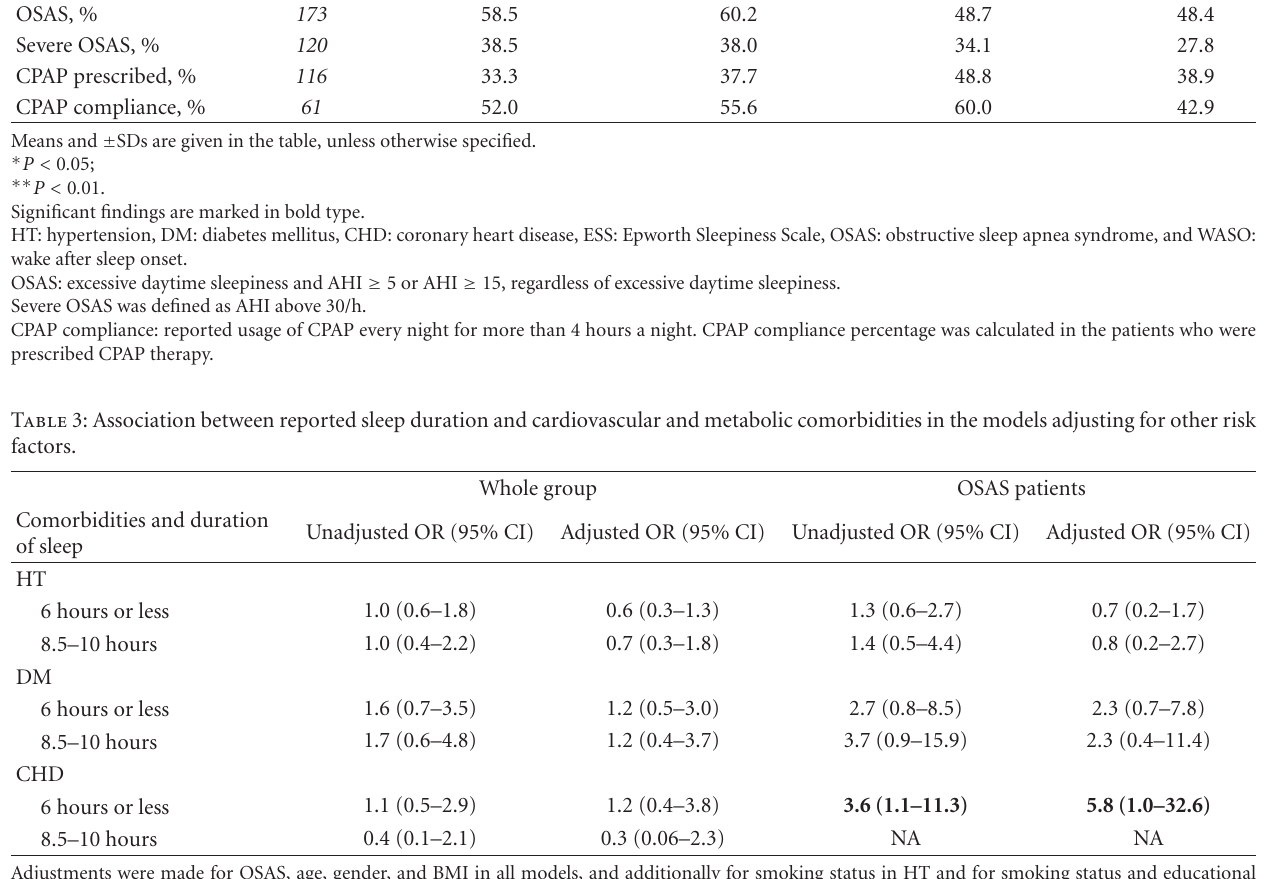
CPAP compliance, % 61